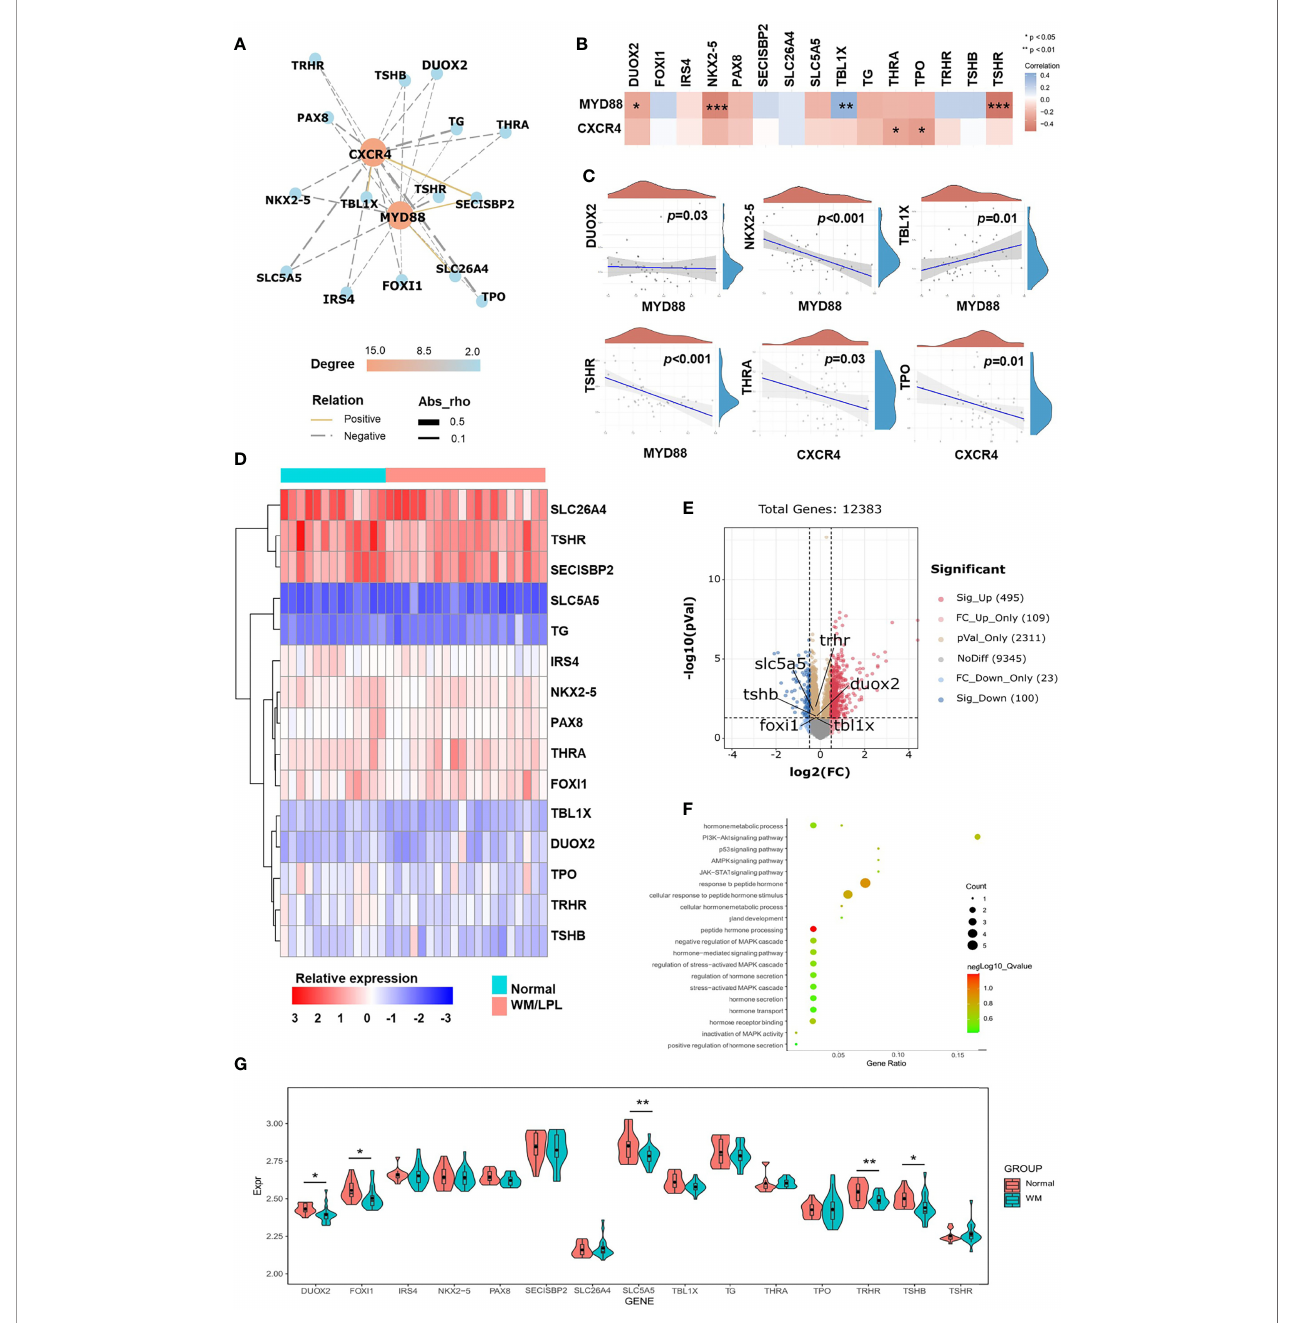
FIGURE 4 | Correlation analyses and differential gene expression analyses between the WM/LPL and healthy donors. (A) Network diagrams of correlation for MYD88 and CXCR4 with thyroid-related genes in the WM/LPL patients. (B) A heat map of the correlation between MYD88, CXCR4, and thyroid-related genes. (C) Spearman correlation analysis of MYD88 and CXCR4 gene expression and thyroid-related genes (DUOX2, NKX2-5, TBL1X, TSHR, THRA, and TPO) expression. (D) Hierarchical clustering analysis of thyroid-related mRNAs between WM/LPL and healthy donors. (E) Volcano plots were constructed using fold-change values and adjusted p . The red point in the plot represents the over-expressed mRNAs and the blue point indicates the under-expressed mRNAs with statistical signi fi cance. (F) The enriched KEGG signaling pathways and GO analysis were selected to demonstrate the primary biological actions of thyroid-related mRNA. (G) The expression distribution of thyroid-related mRNA in WM/LPL and control groups. Asterisks represent levels of signi fi cance (* p < 0.05, ** p < 0.01, *** p <